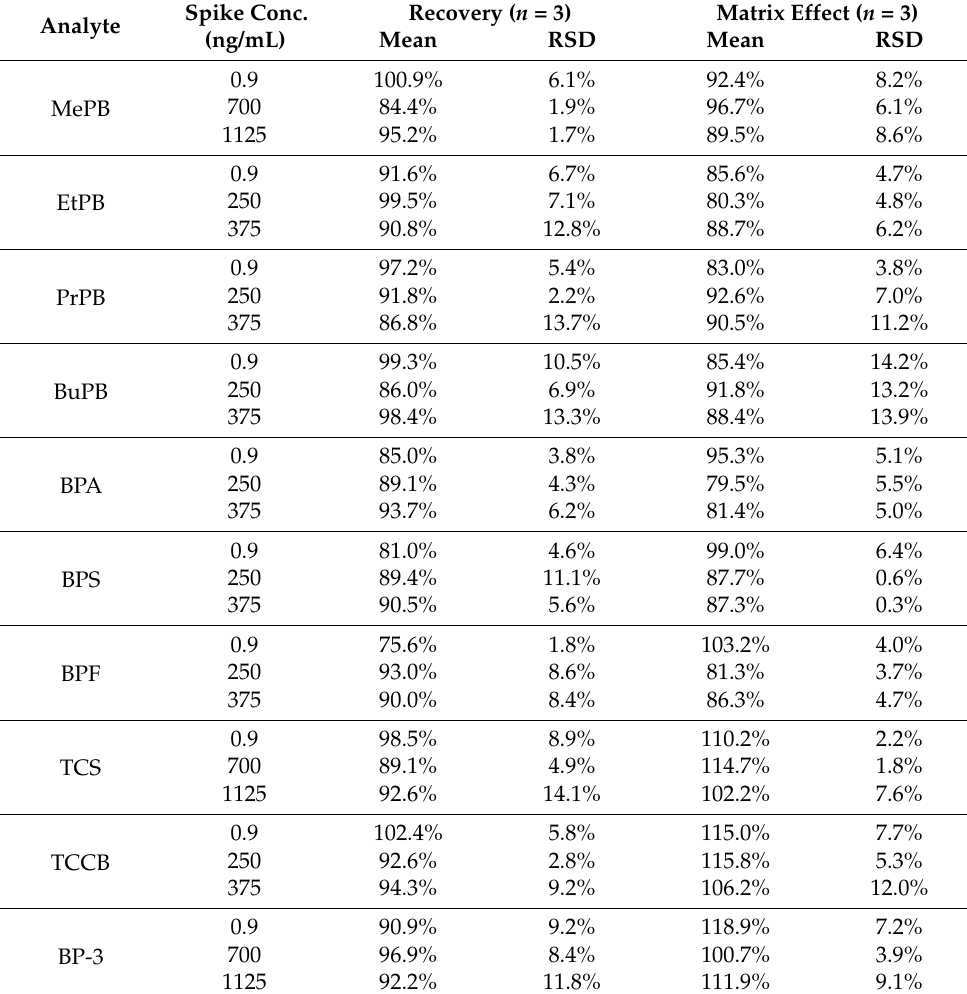
Table 2. Recovery and matrix effect of target EDC spike in artificial urine.